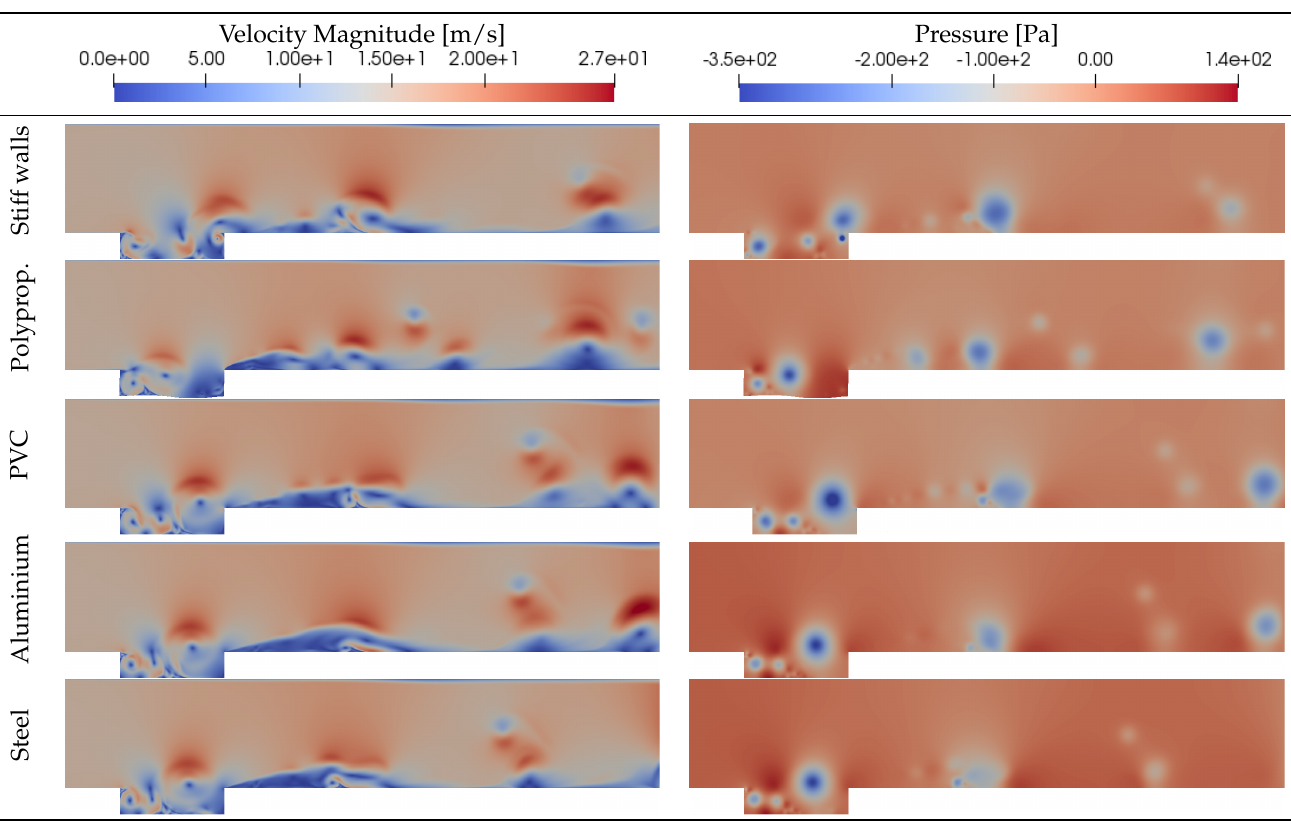
Table 7. Contours of velocity and pressure for reference models and FSI models with different materials at t = 1